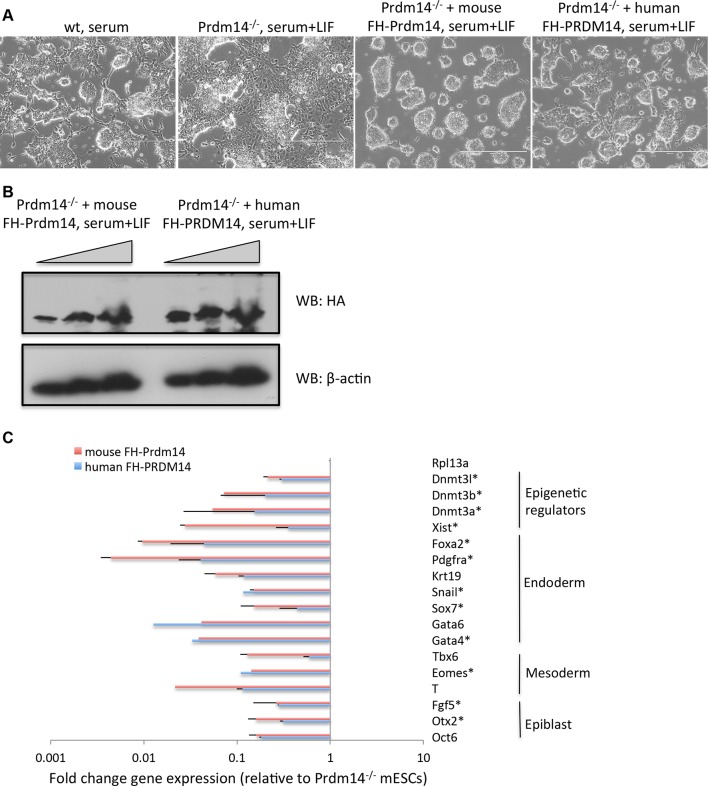
Human PRDM14 can substitute for the mouse Prdm14 in mESCs.(A) Morphological changes in Prdm14−/− mESCs and those reconstituted with mouse or human FH-PRDM14 cDNA, respectively. Note that all lines were grown under serum+LIF conditions. (B) Western blot shows that both human and mouse Prdm14 proteins were expressed at similar levels in the reconstituted lines. (C) RT-qPCRs measuring changes in gene expression in lines reconstituted with human or mouse Prdm14 relative to the Prdm14−/− line. Genes marked with an asterisk denote direct mouse Prdm14 targets from ChIP-seq. ChIP-seq, chromatin immunoprecipitation with sequencing; LIF, leukemia inhibitory factor; RT-qPCRs, quantitative reverse transcription-polymerase chain reaction.